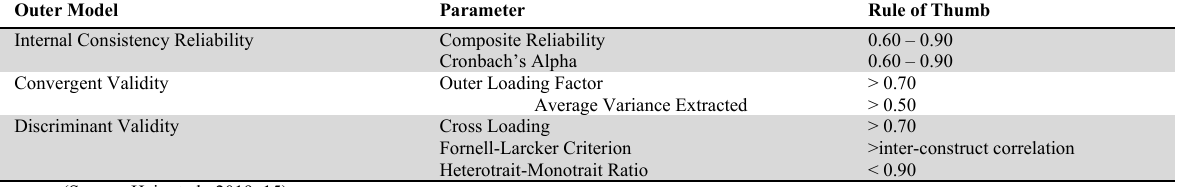
Rule of Thumbs, Reflective Measurement Model Outer Model